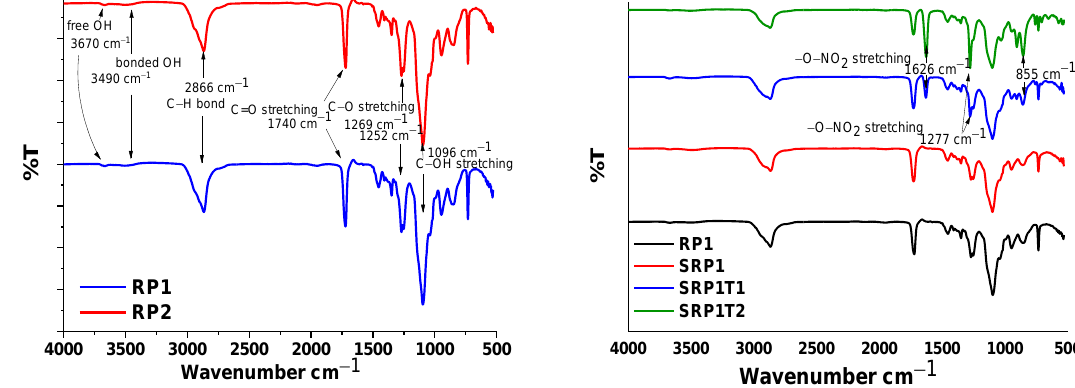
Figure 2. FT-IR spectra of RP1 and RP2 polyols and mixtures SRP1, SRP1T1, and SRP1T2.